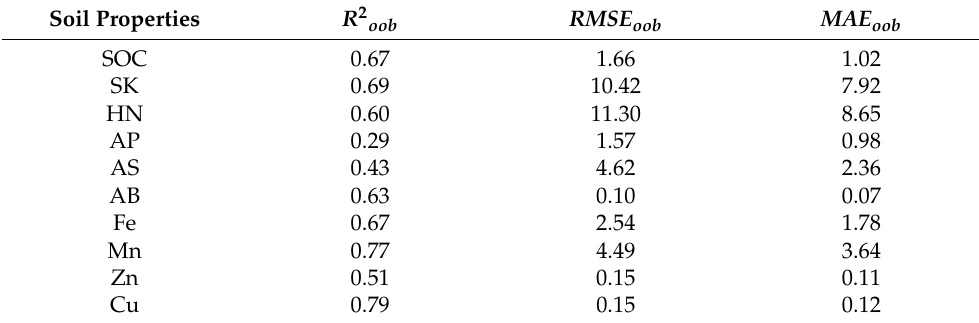
Table 1. Performance of random forest models in the prediction of soil physicochemical properties. (SOC indicates soil organic carbon, SK indicates soil available potassium, AP indicates soil available phosphorus, AS indicates available sulfur, HN indicates soil hydrolyzed nitrogen, AB indicates soil available boron; Fe, Mn, Zn, and Cu indicate soil iron, manganese, zinc, and copper; R 2 oob indicates coefficient of determination, RMSE oob indicates root mean square error, MAE oob indicates mean absolute